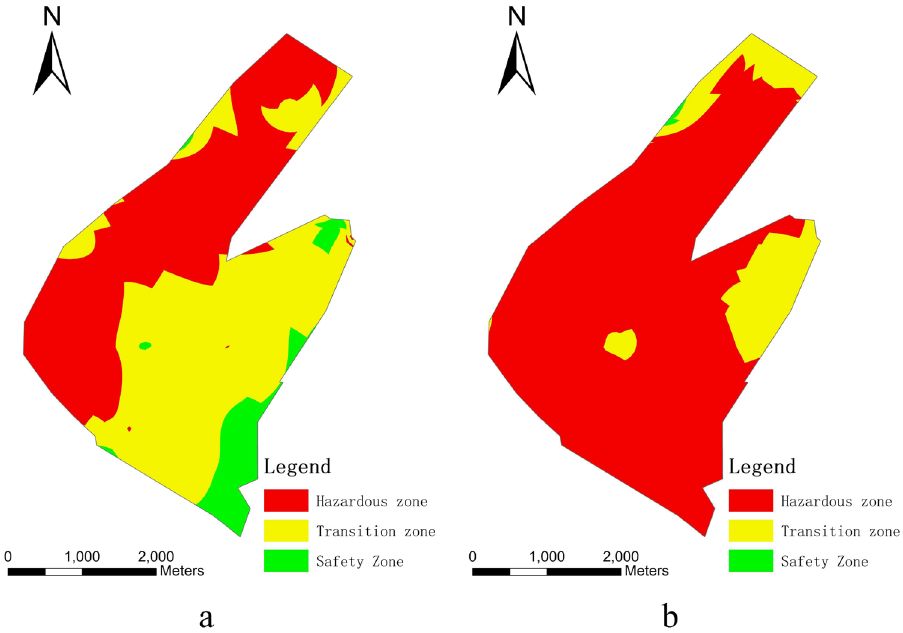
Figure 5. Map of water inrush coefficient method results: ( a ) Ordovician limestone aquifer; ( b ) Benxi limestone aquifer. Images are created using the ArcGis, https:// www. esri. com/ en- us/ arcgis/ produ cts/